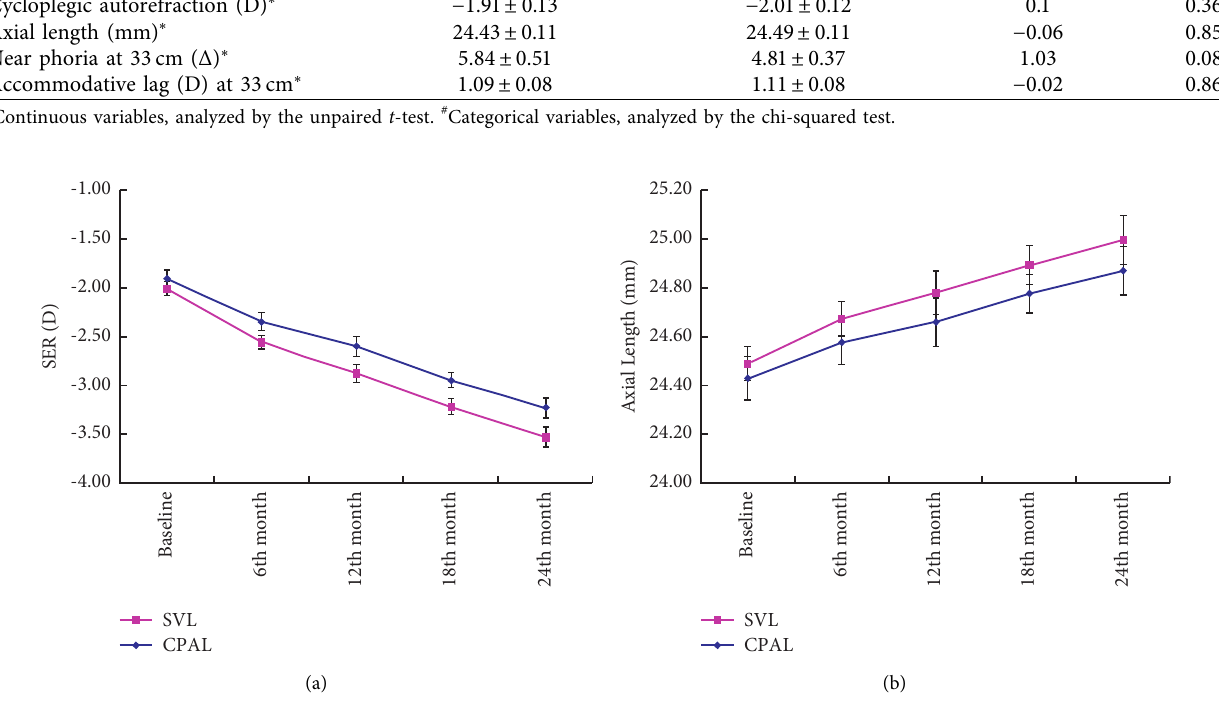
Figure 3: (a) Mean cycloplegic autorefraction (spherical equivalent refraction, SER) and (b) mean axial length for both the groups at each visit. Error bars: ±